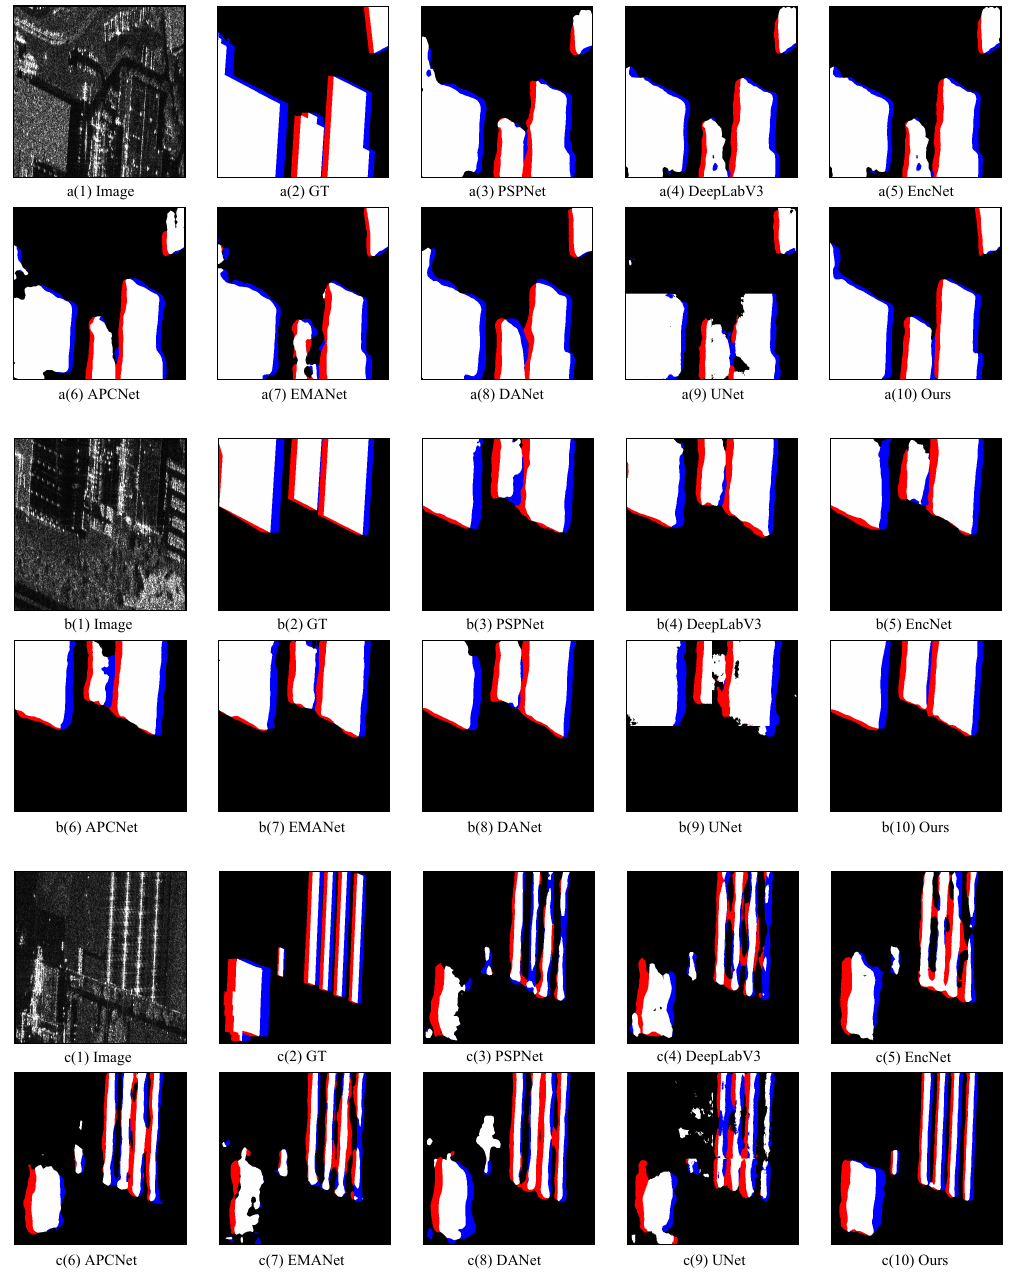
Figure 9. Inference results of the first set of